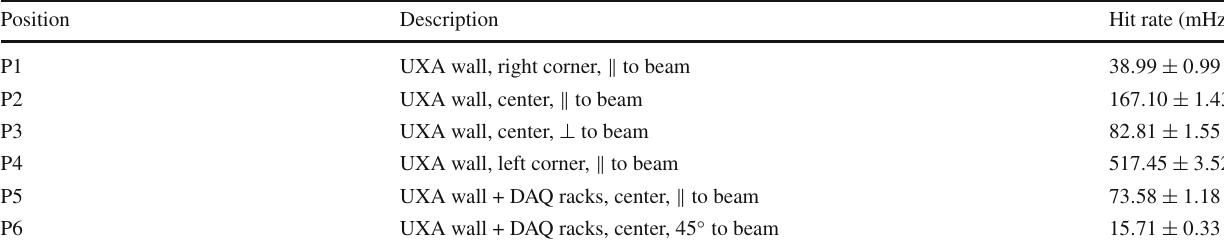
Table 5 Average hit rates measured during stable beam, at various configurations. Table reproduced from Ref. [191] Position Description Hit rate (mHz) P1 UXA wall, right corner, (cid:20) to